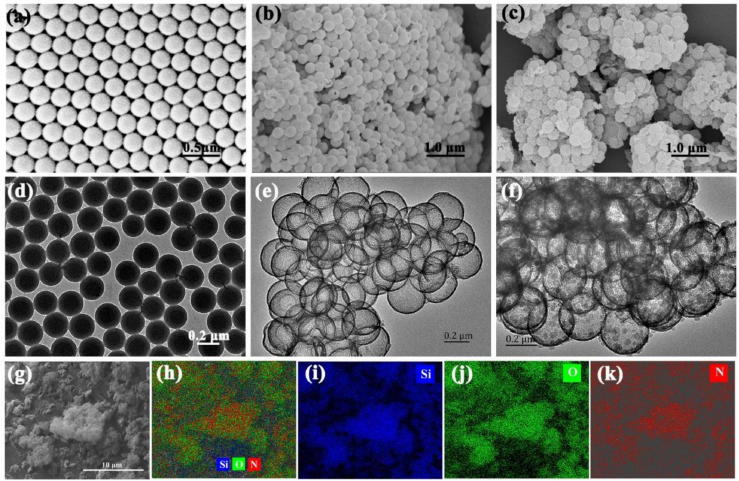
Figure 2. SEM and TEM images of monodisperse core-shell spheres (MLSs) ( a , d ), HMSNs ( b , e ) and PPy / HMSNs ( c , f , g ), and EDS mapping images of overlapped Si, O, N ( h ), Si ( i ), O ( j ), and N ( k ) of PPy /